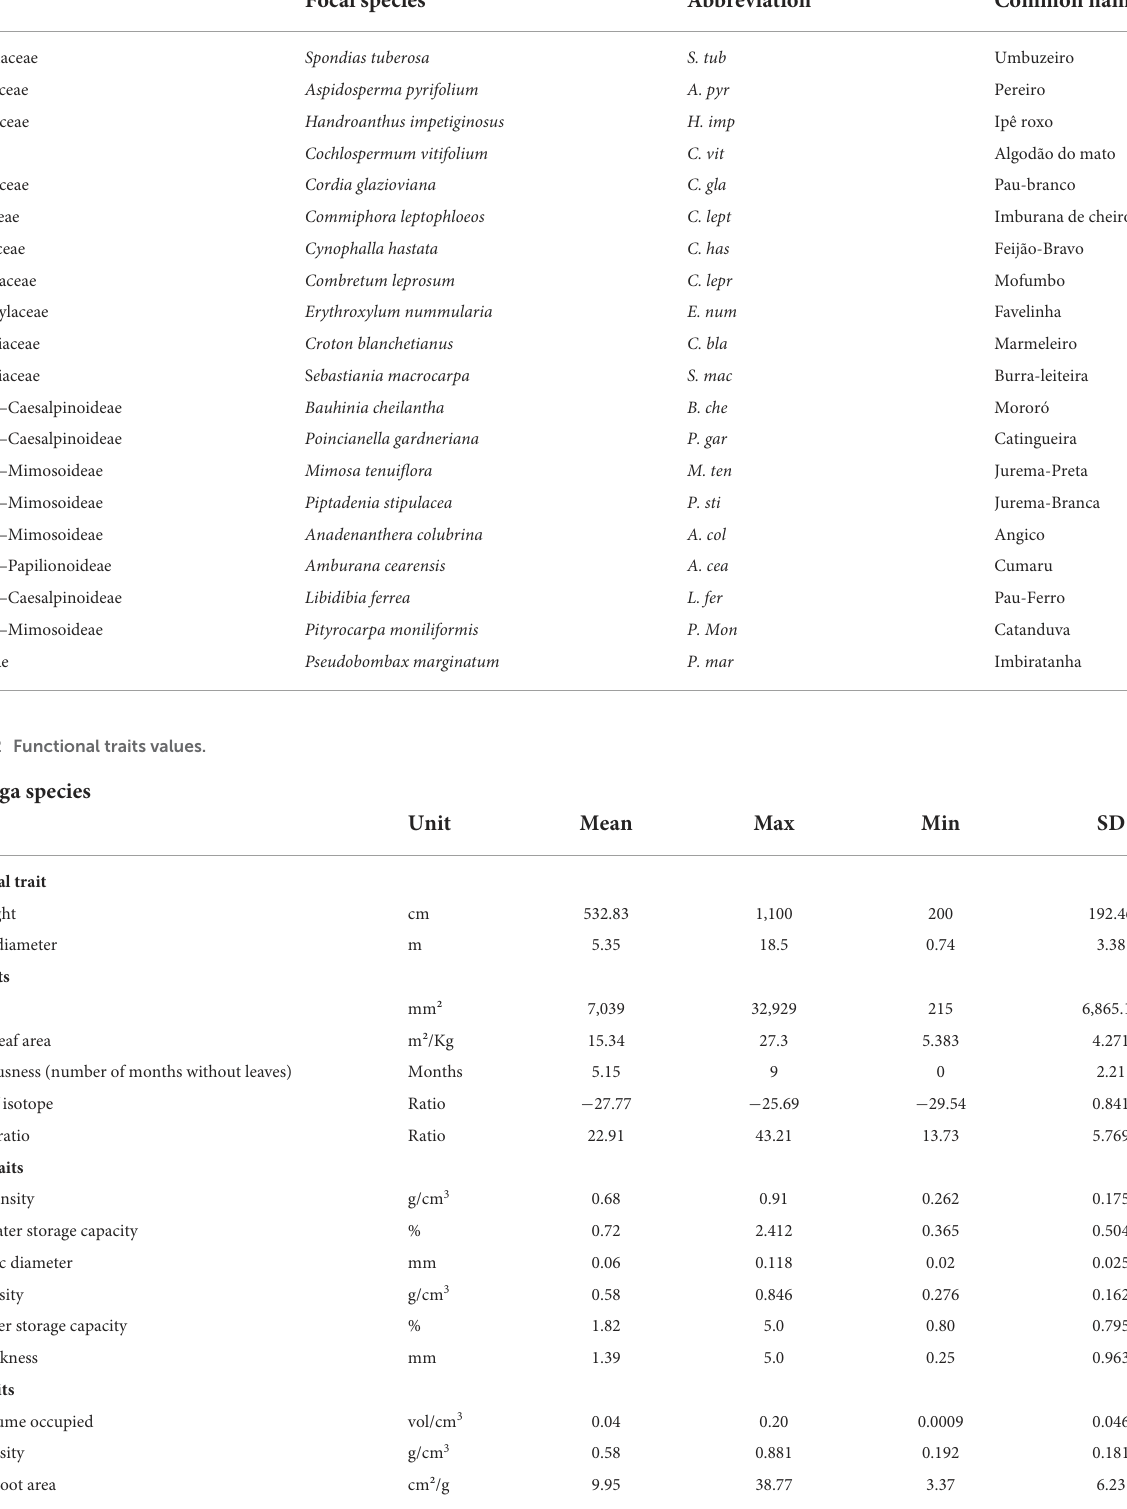
TABLE 1 Information of scientific name and popular name of the studied trees from the Caatinga seasonally dry tropical forest. Family Focal species